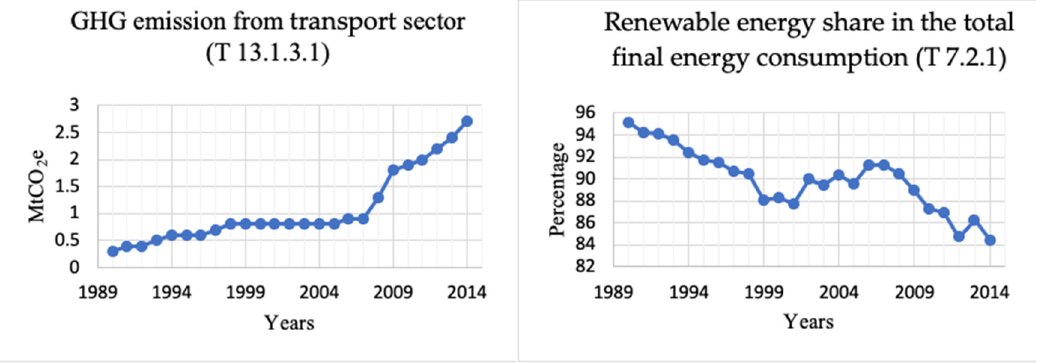
Figure 13. GHG emission from transport sector ( left ) and renewable energy share in total final energy consumption ( right ).